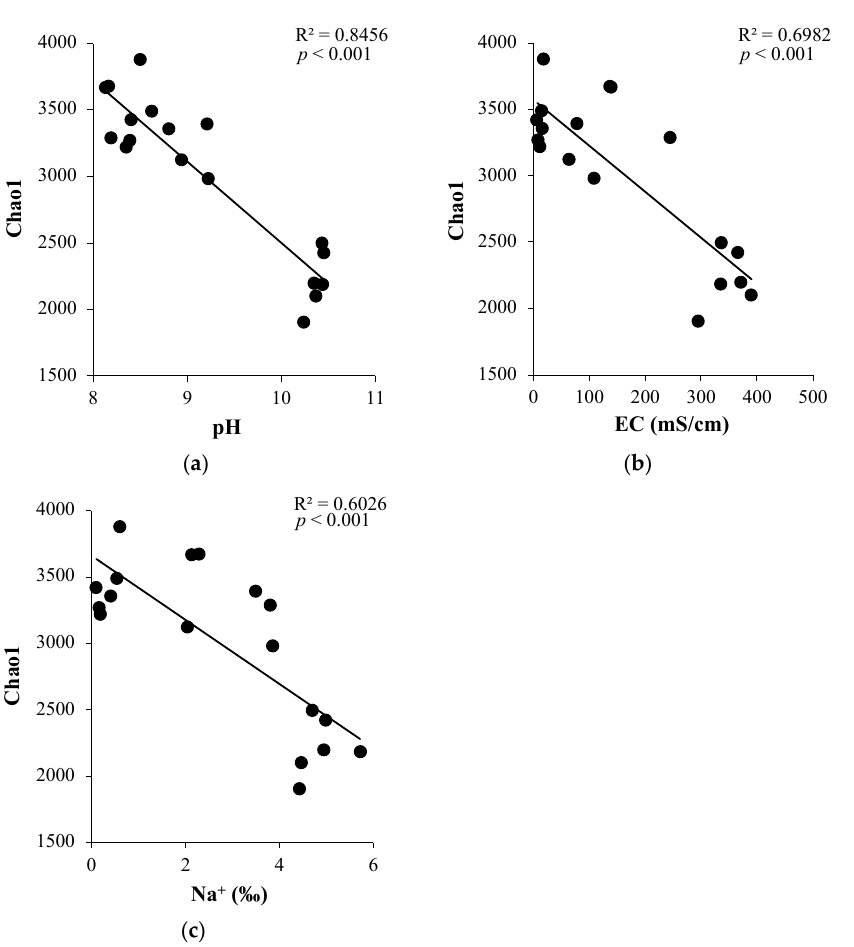
Figure 3. Linear regression between bacterial species richness and soil physiochemical properties. ( a ) Relationship between bacterial species richness (Chao1) with soil pH. ( b ) Relationship between bacterial species richness with soil EC. ( c ) Relationship between bacterial species richness with Na + concentration in soil.